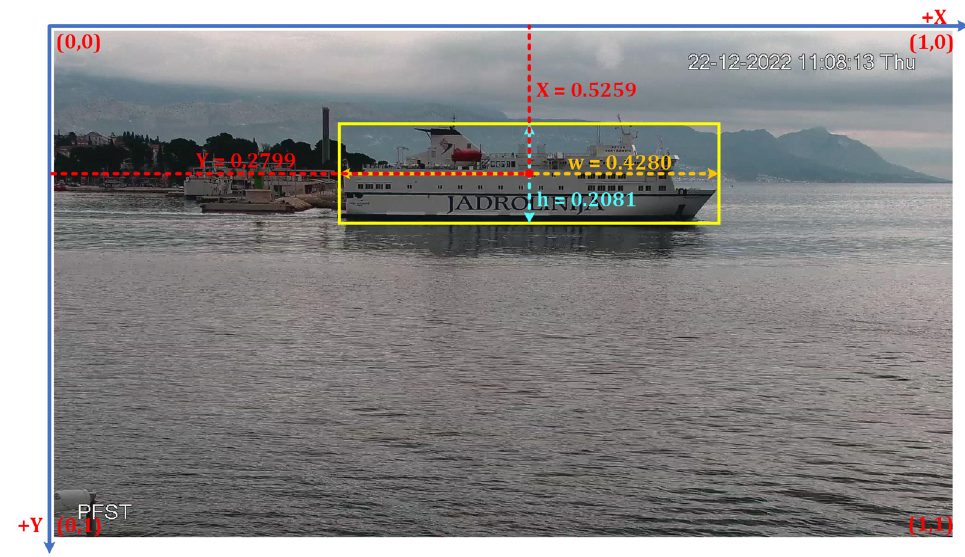
Figure 4. Annotated image from the proposed dataset.